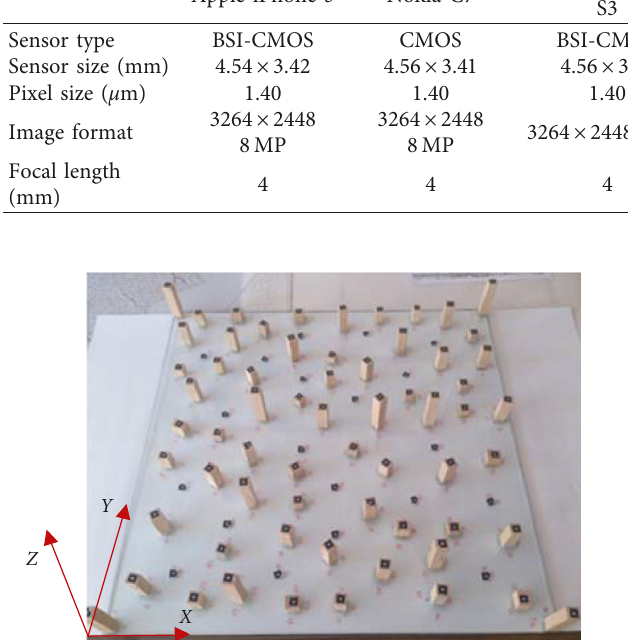
Figure 1: A photograph of the test